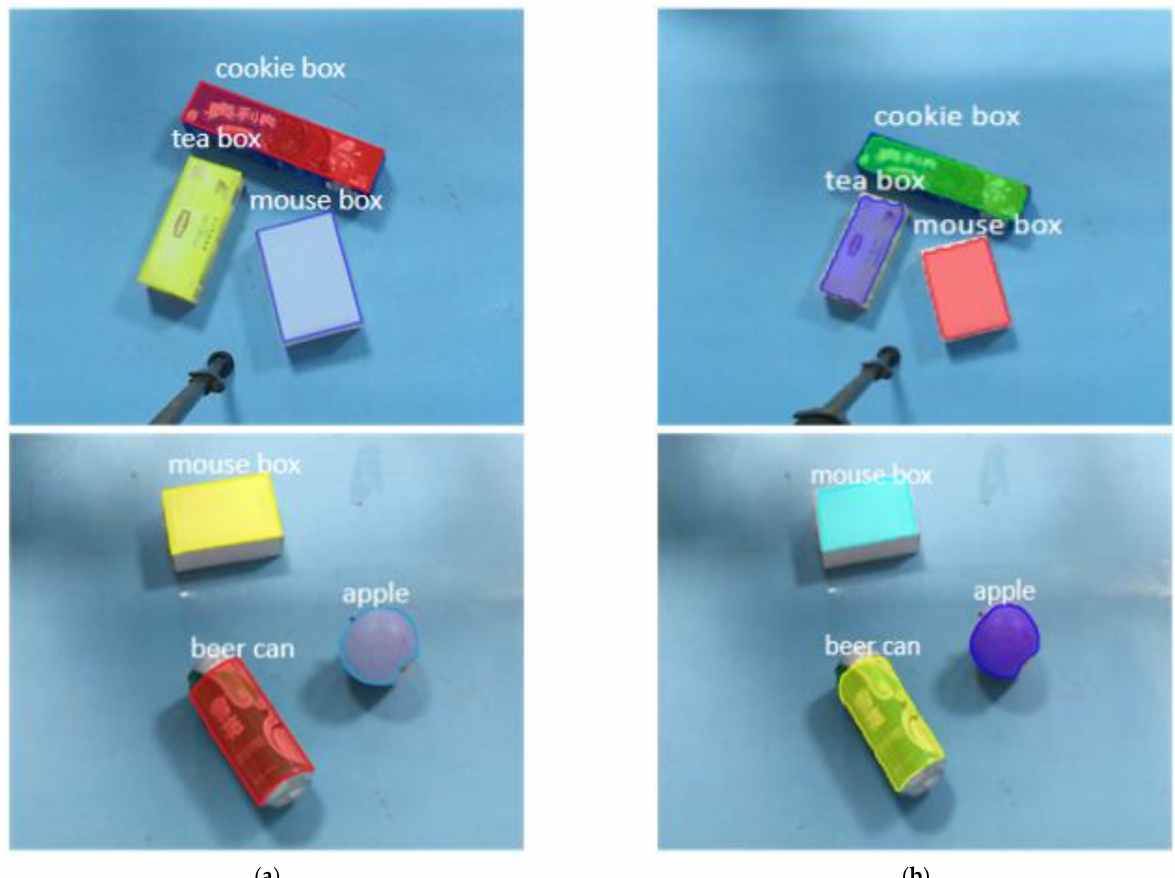
Figure 18. The actual scene instance segmentation network segmentation effect ( a ) for network detection results and ( b ) for unoptimized network detection